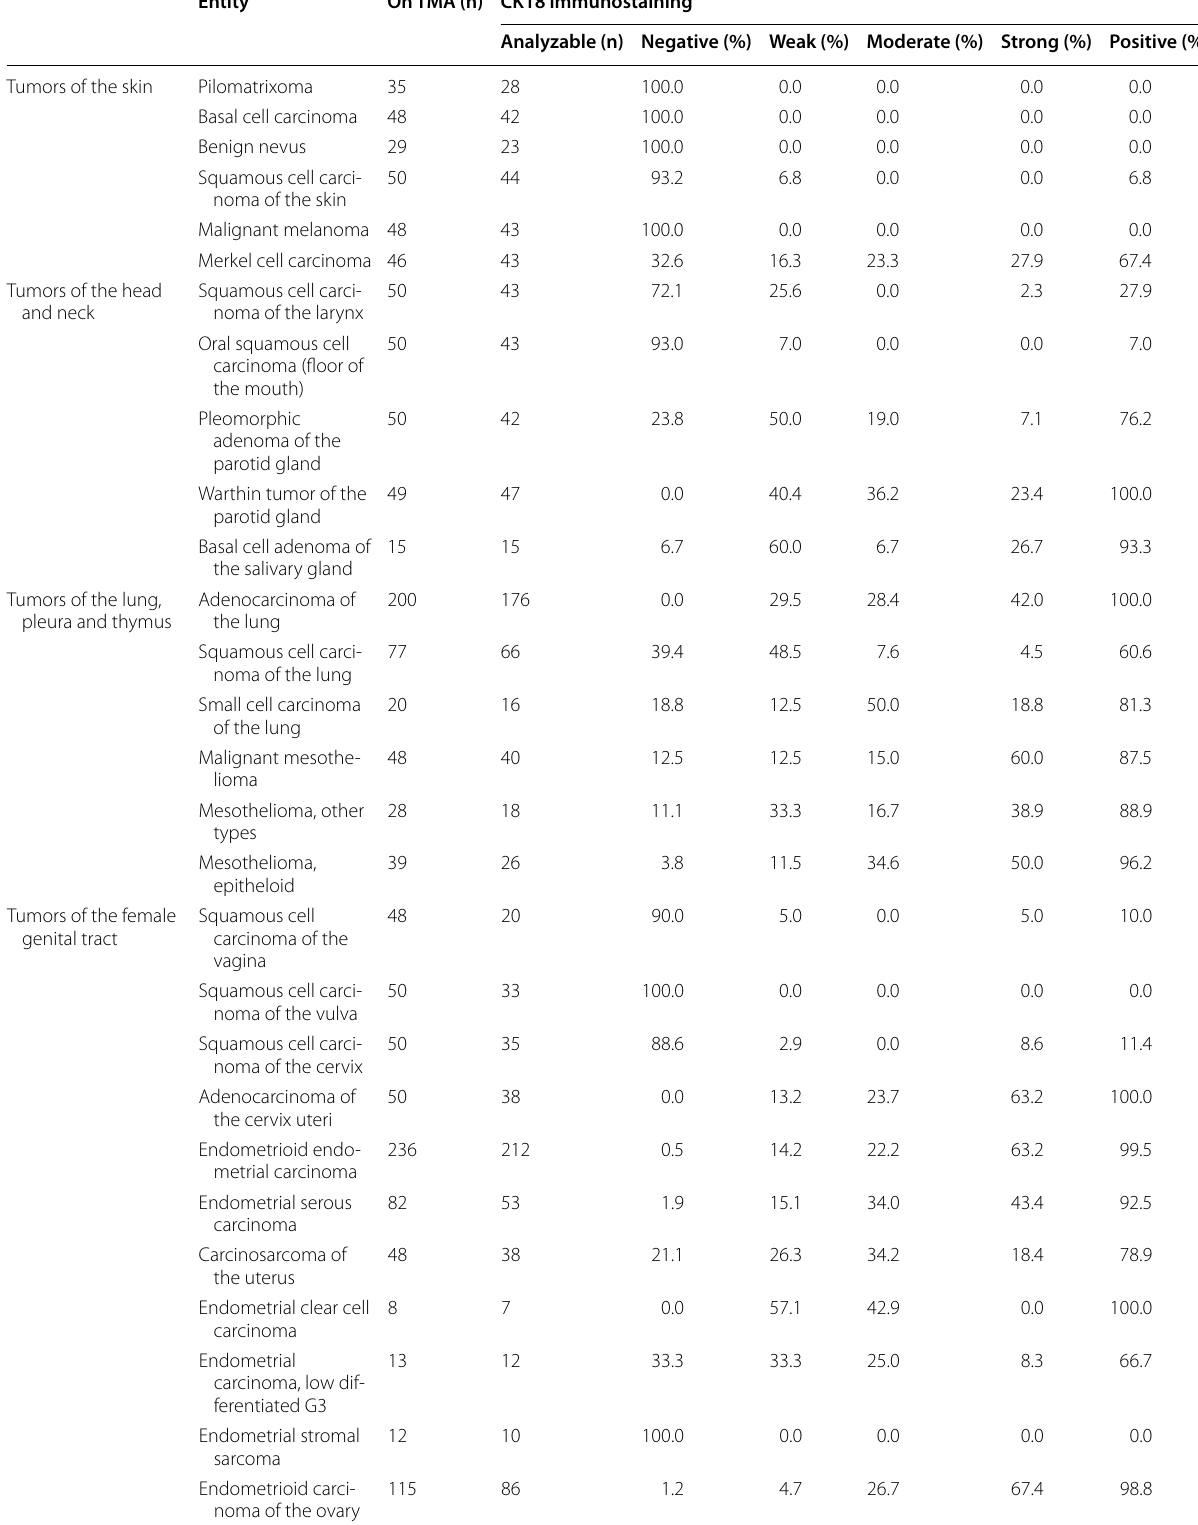
Table 1 Cytokeratin 18 immunostaining in human tumors Entity On TMA (n) CK18 immunostaining Analyzable (n) Negative (%) Weak (%) Moderate (%) Strong (%) Positive (%) Tumors of the